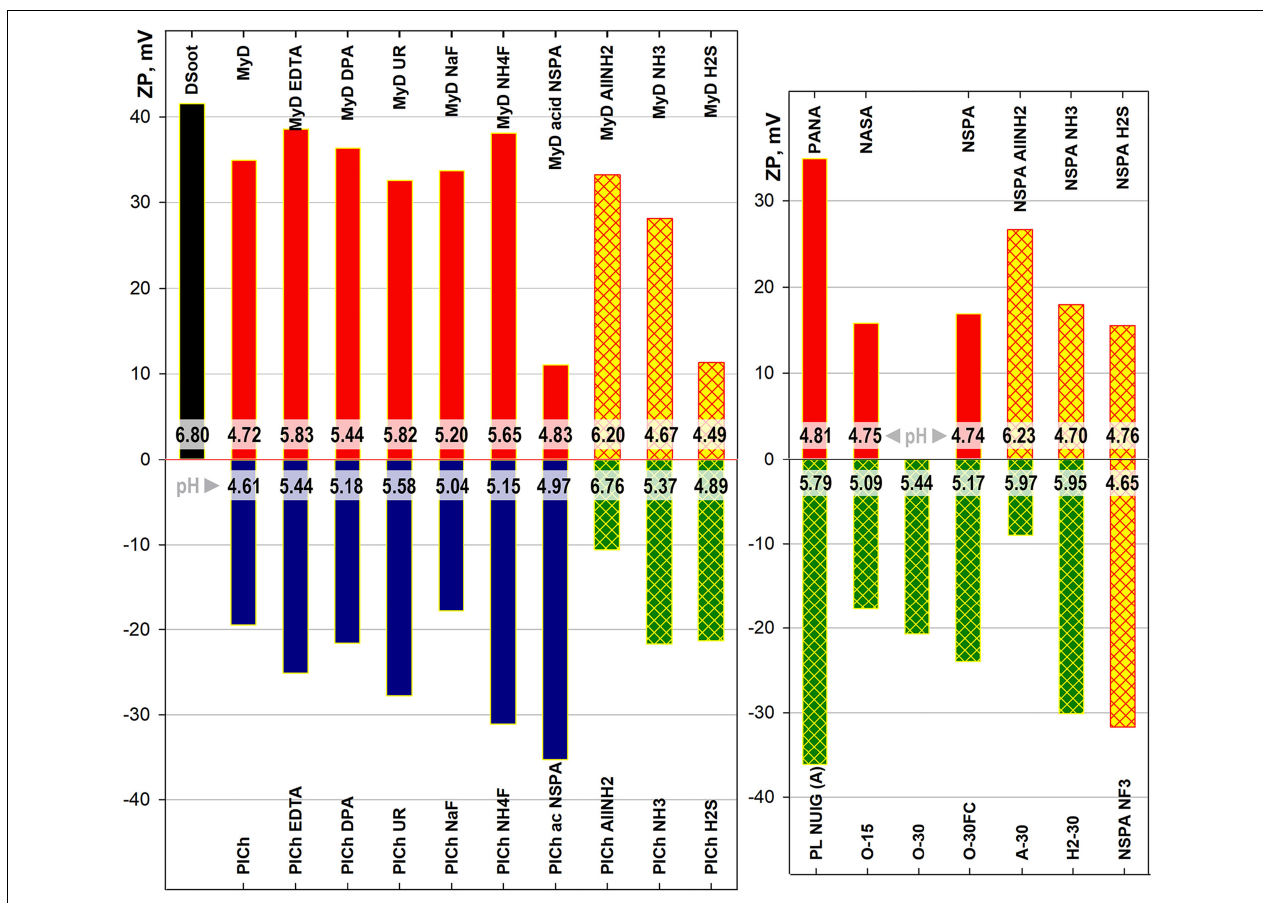
FIGURE 7 | Electrokinetic (zeta-) potential and intrinsic pH ranges (strips close to base) of 0.05% ND suspensions in DI